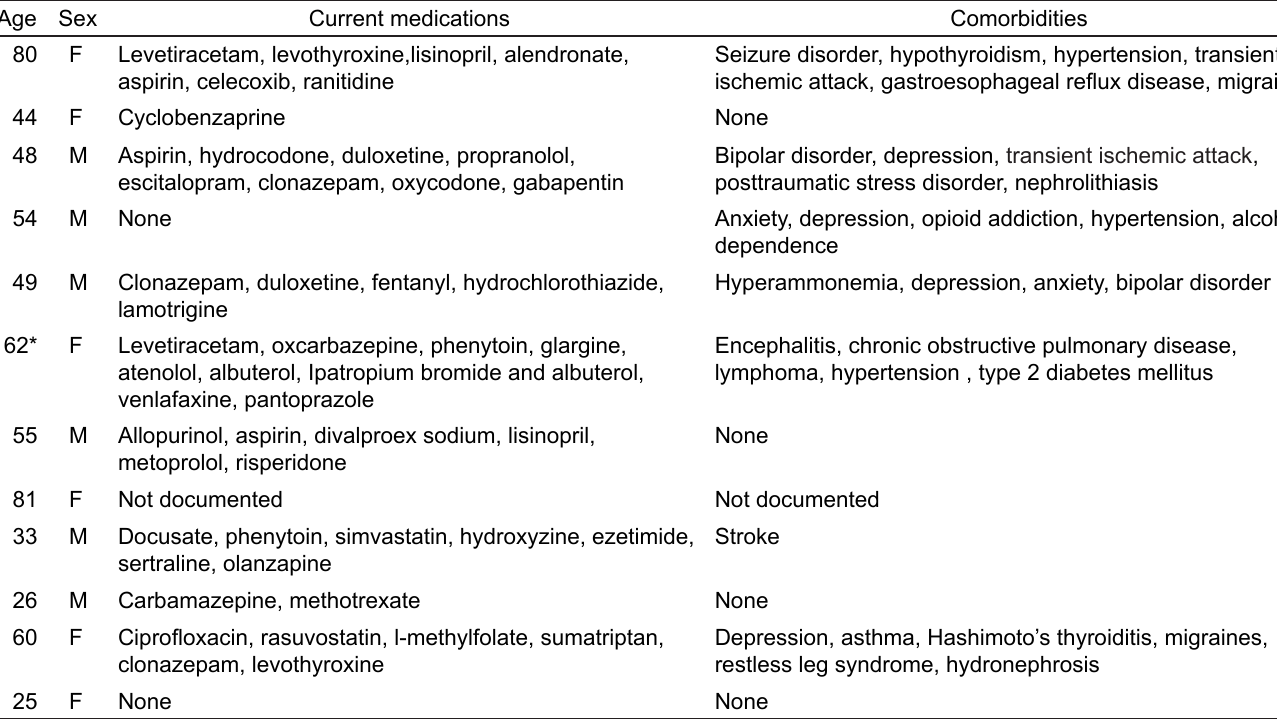
Table. Demographics, medications, and comorbidities of study patients.